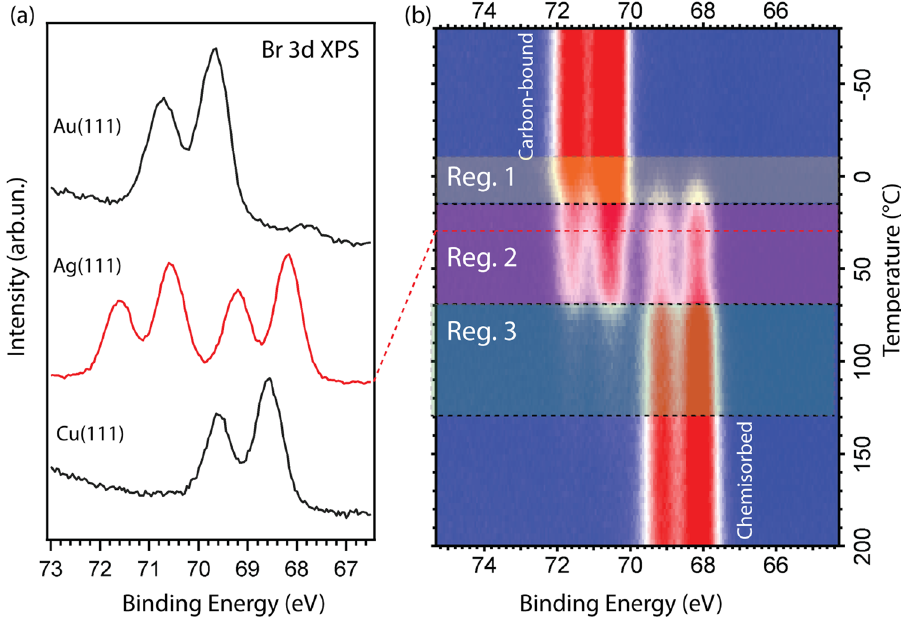
Figure 1. ( a ) Comparison of the RT Br 3d XPS spectra from DBBA molecule on substrates with different reactivity: Au(111), Ag(111) and Cu(111). ( b ) Evolution of the Br 3d XPS spectrum for DBBA/Ag(111) mapped as a function of increasing sample temperature. The temperature varies from − 80 °C to 200 °C. The red dashed line marks the spectrum corresponding to RT. Three regions, Reg.1, Reg.2 and Reg.3, indicate different stages of the DBBA debromination process on Ag(111) (see text for more information). The photon energy is 170 eV. For ( b ) the same color scale was used at all temperatures, spectra were normalised to the ring